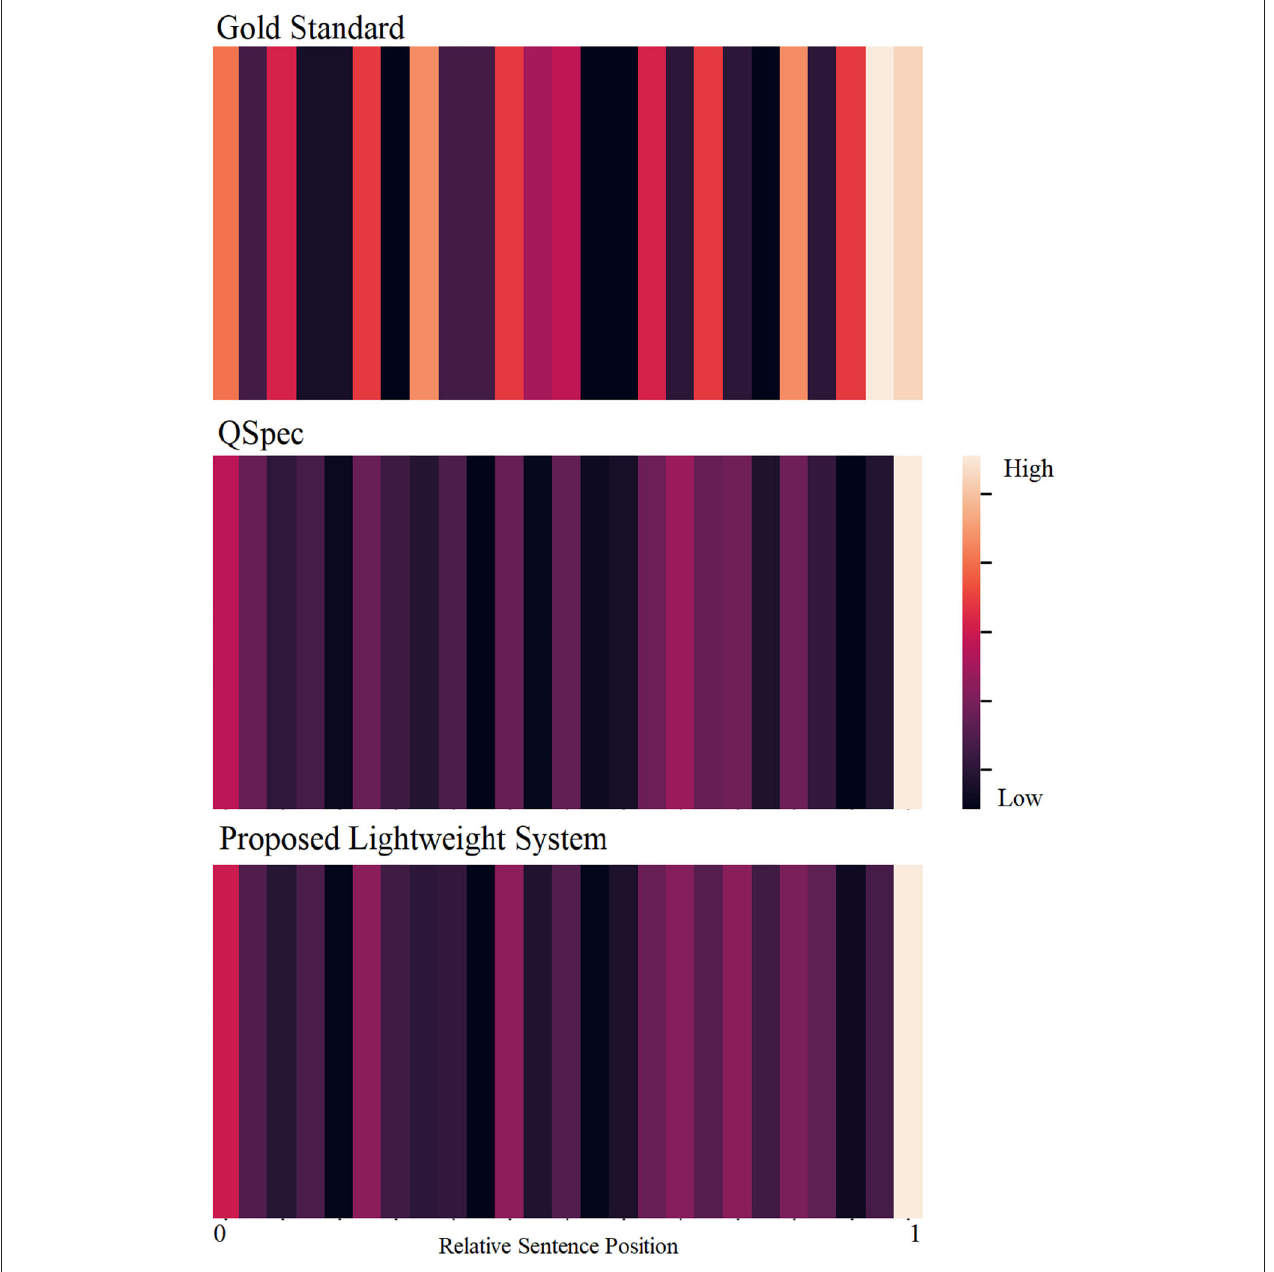
FIGURE 2 | Distributions of relative sentence positions of the gold standard summary sentences (top), and automatically-generated summaries (QSpec: middle; proposed system: bottom).